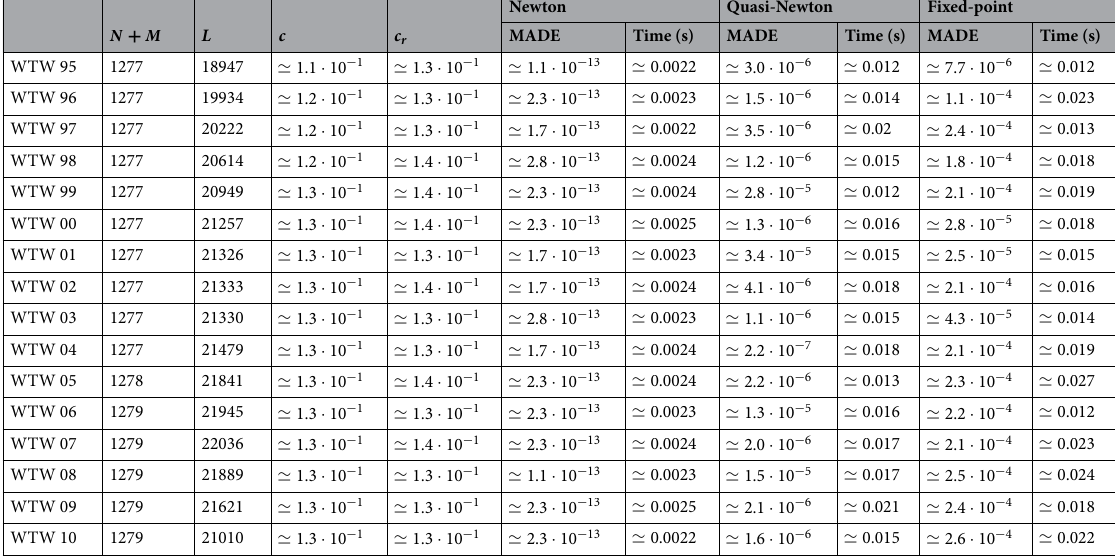
Table 3. Performance of Newton’s, quasi-Newton and the fixed-point algorithm to solve the reduced system of equations defining the BiCM, on a set of real-world BiUNs (of which basic statistics as the total number L /( N M ) , are provided). All algorithms of nodes, N , the total number of links, L , and the connectance, c = · 10 L ( 10 θ) stop because the condition is satisfied. For what concerns both accuracy and speed, the 2 − � ||∇ || ≤ best performing method is Newton’s one, followed by the quasi-Newton and the fixed-point recipes. Only the results corresponding to the best choice of initial conditions are